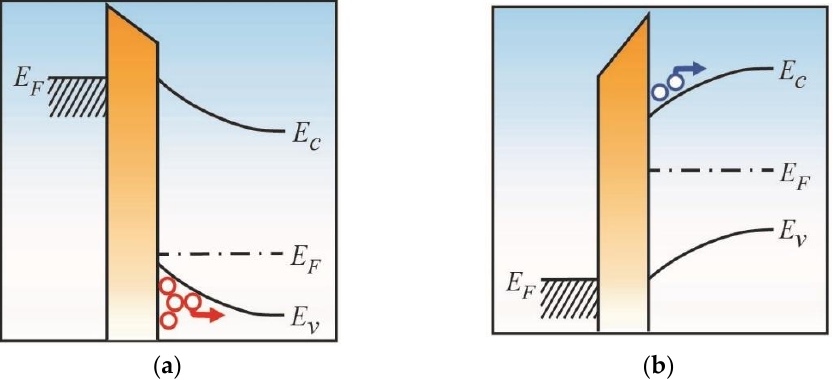
Figure 6. Energy band diagram of the structure and model of photoresponse formation under reverse ( a ) and forward ( b ) bias voltage.